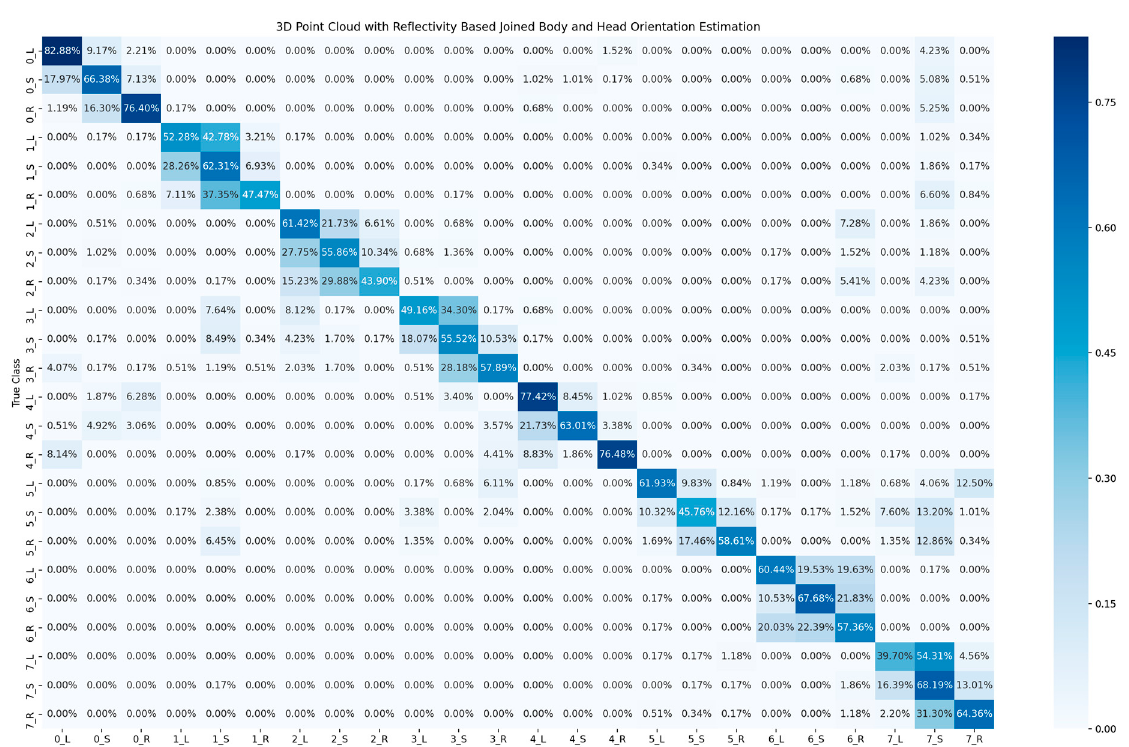
Figure 7. Confusion matrix of cyclist joined body and head orientation estimation using 3D point cloud data with reflectivity.